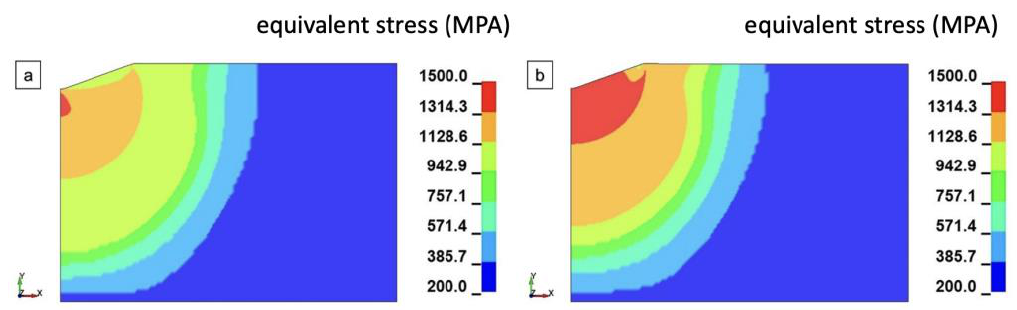
Figure 8. Equivalent stress contours of ( a ) titanium substrate model and ( b ) MMNC-coated model at 500 gf peak load. The indenter has not been shown for clarity purposes. The units are in MPa.